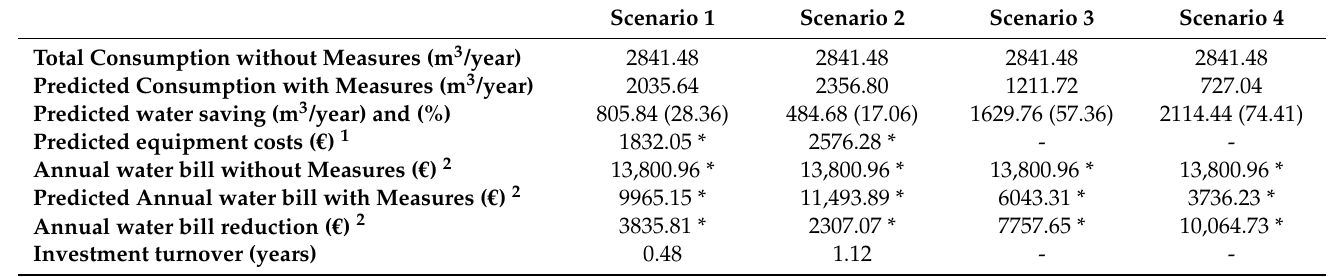
Table 6. Water consumption and cost without and with water-saving measures and invest- ment turnover.